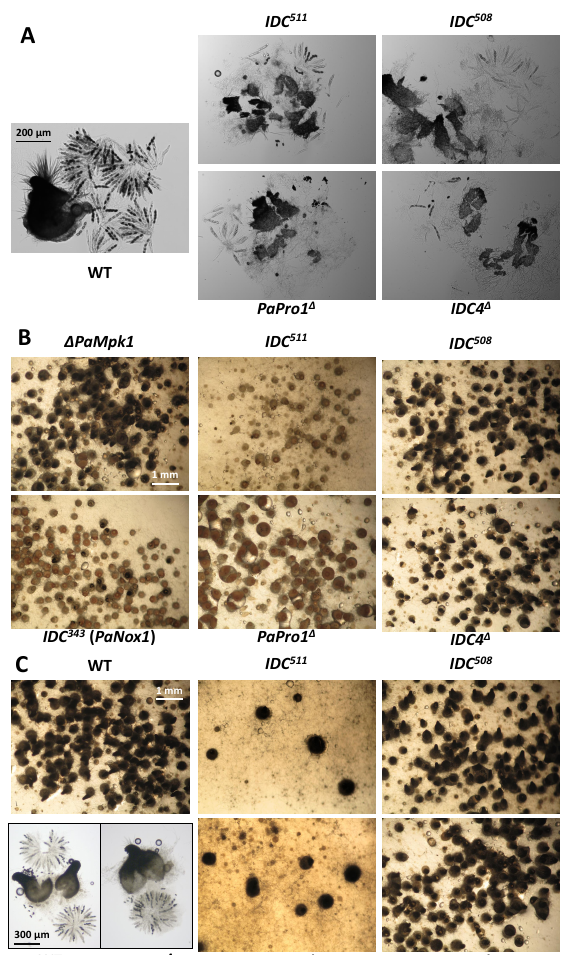
Figure 2. Fertility defect of the IDC4 and PaPro1 mutants. ( A ) Grafting experiments show that IDC4 and PaPro1 are required in the mycelium during fruiting body maturation. Two-day-old wild type perithecia (WT) grafted onto wild-type mycelia continued their development and produced many asci. On the contrary, those grafted onto IDC4 or PaPro1 mutant strains failed to mature properly, i.e., remained small and differentiated few abortive asci. ( B ) Mosaics of the indicated strains with psk1-193 of opposite mating show that IDC4 is dispensable in the fruiting body, since the mosaic differentiated pigmented fruiting bodies having the IDC4 mutants as the maternal parent. On the contrary, PaPro1 is necessary in the fruiting body since only unpigmented perithecia were produced. The controls are the ∆ PaMpk1 mutant used to show that PaMpk1 is dispensable in the developing fruiting body and the IDC 343 mutant of PaNox1 used to show that PaNox1 is required in the developing fruiting body [5]. Note that in the case of the PaNox1 mutants a few perithecia with a pigmented neck were obtained as previously described [5], while none were produced in the case of the two PaPro1 mutants. ( C ) mosaics with the ∆ mat mutant resulted in abundant ascospore-bearing fruiting body production in the case of the IDC4 mutants, confirming that IDC4 is dispensable in the fruiting body, but also for fertilization. On the contrary, few abnormal and/or few ascospore-bearing normal-looking perithecia were obtained with both PaPro1 mutants, showing that PaPro1 is required for fertilization and/or at an early stage during formation in the zygotic tissue of the fruiting body. Pictures at the bottom left show that rosettes of asci are like those of the wild type in the few perithecia that developed in the trikaryons made with PaPro1